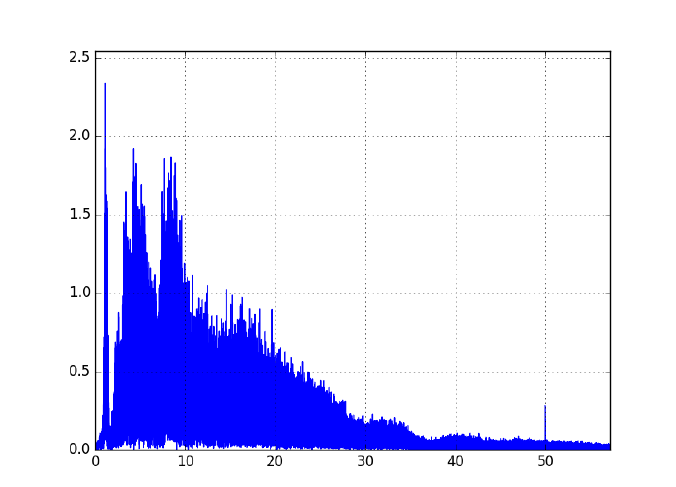
Figure 11. Noised results of the Fourier transform of a signal collected from one